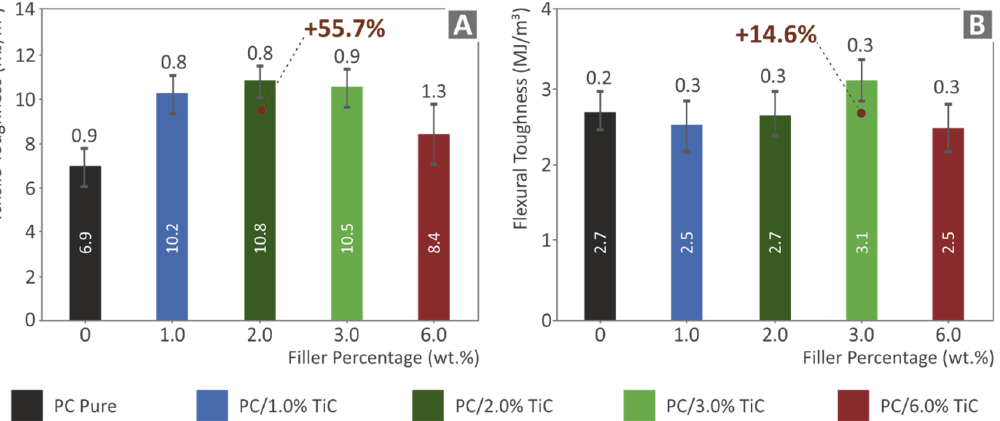
Figure 11. For all materials tested: ( A ) mean tensile toughness (MJ/m 3 ) and deviation; ( B ) mean flexural toughness (MJ/m 3 ), and deviation.